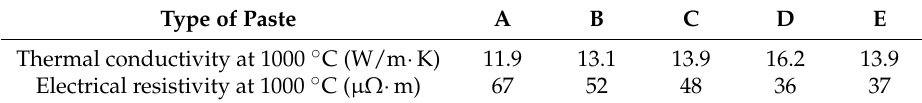
Figure 4. Relation between flexural strength and crushing strength. Table 8. Thermal conductivity and electrical resistivity at 1000 °C.